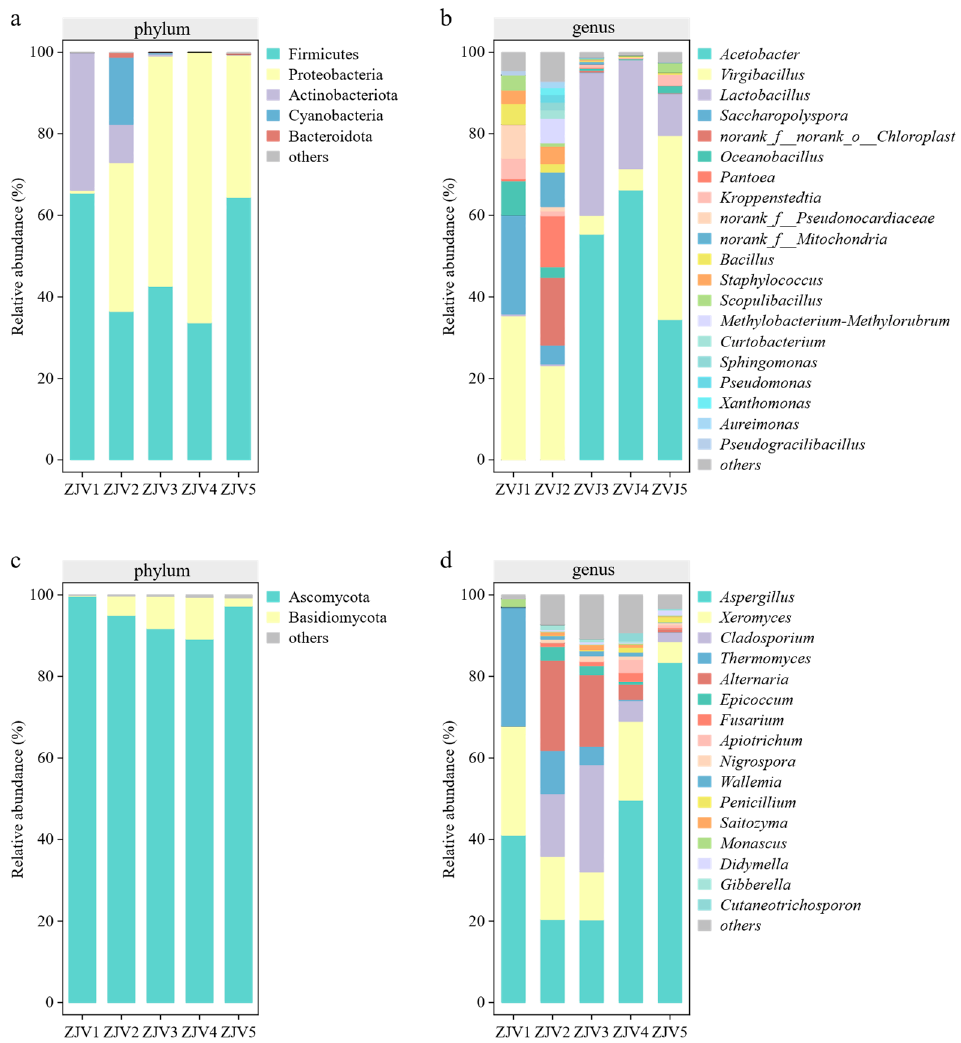
Figure 4. Species diversity and abundance of ZJV at the level of phylum (( a ) bacteria; ( c ) fungi) and genus (( b ) bacteria; ( d ) fungi).